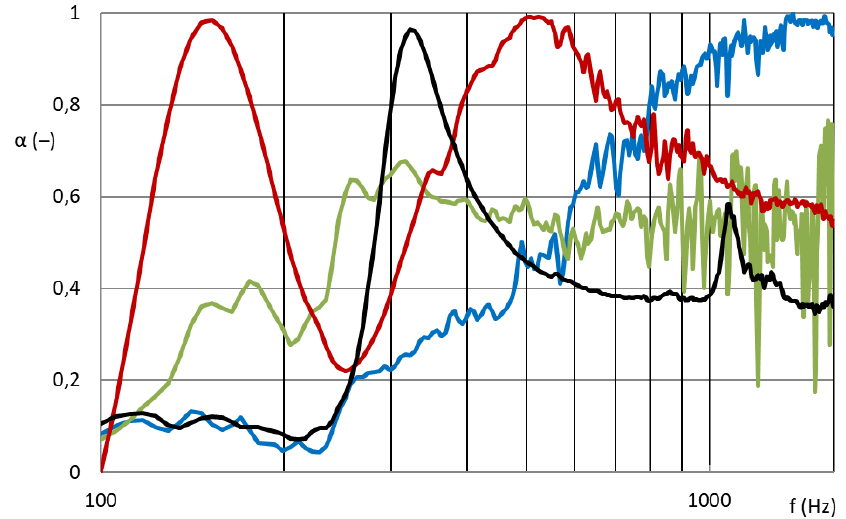
Nanomaterials 2023 , 13 , x FOR PEER REVIEW 10 of 15 Figure 7. Sound absorption coefficient depending on sound frequency (100–1600 Hz). Nanofibrous Figure 7. Sound absorption coefficient depending on sound frequency (100 – 1600 Hz). Nanofibrous membrane PA6022 on the grid; blue: M21; green: M7; red: M27; black: M13. membrane PA6022 on the grid; blue: M21; green: M7; red: M27; black: M13.